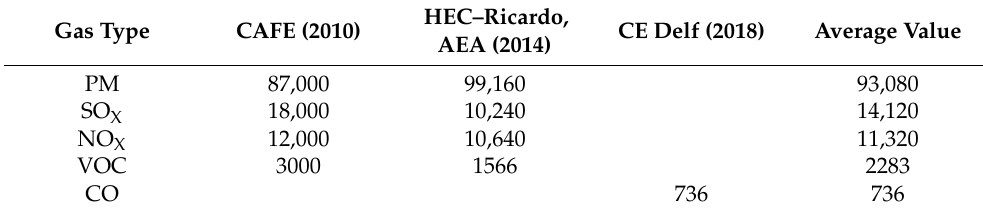
Table 11. Unit values of pollution costs by gas type (in EUR/t).